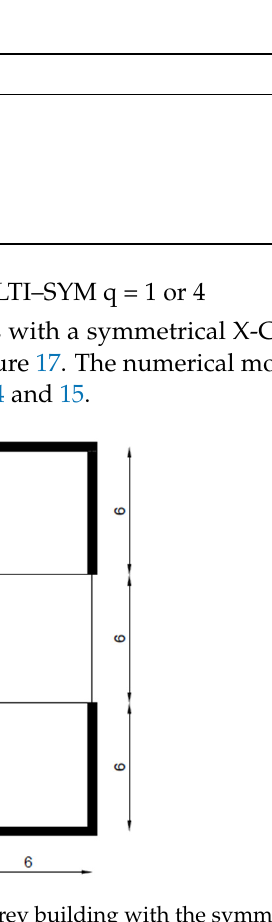
Figure 17. Plan of the multi-storey building with the symmetrical X-CBF configuration (case studies 5 and 6).